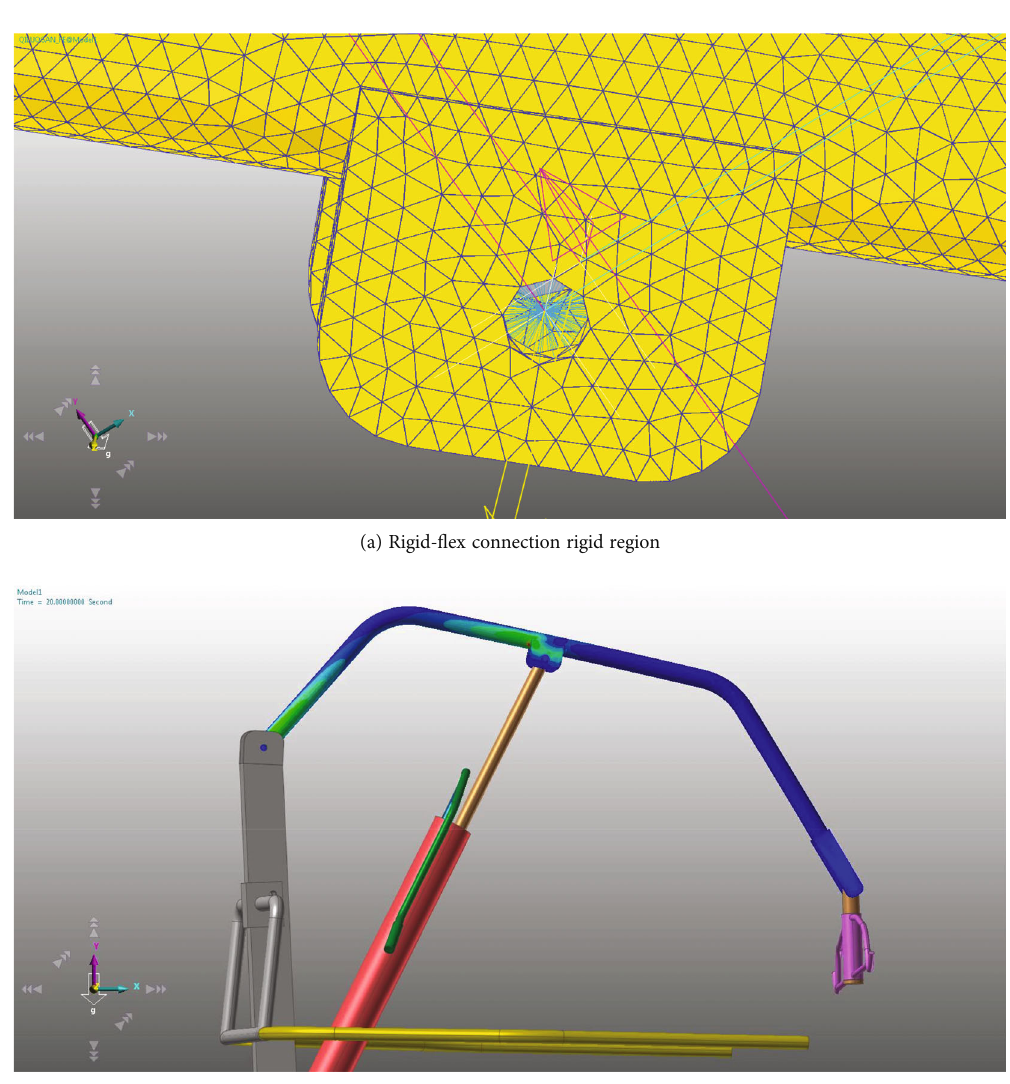
Figure 4: The rigid- fl ex connection rigid region is as shown in Figure4(a) and the stress coutor of the patient rehabilitation transfer device is as shown in